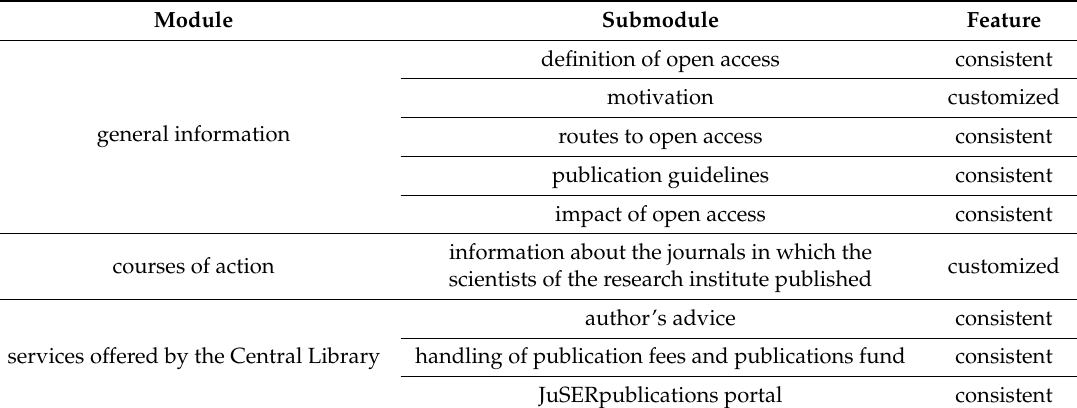
Table 1. The modularized structure of the content presented at the events in the research institutes, including the submodules and details of whether they were consistent or had to be customized for each research institute before the